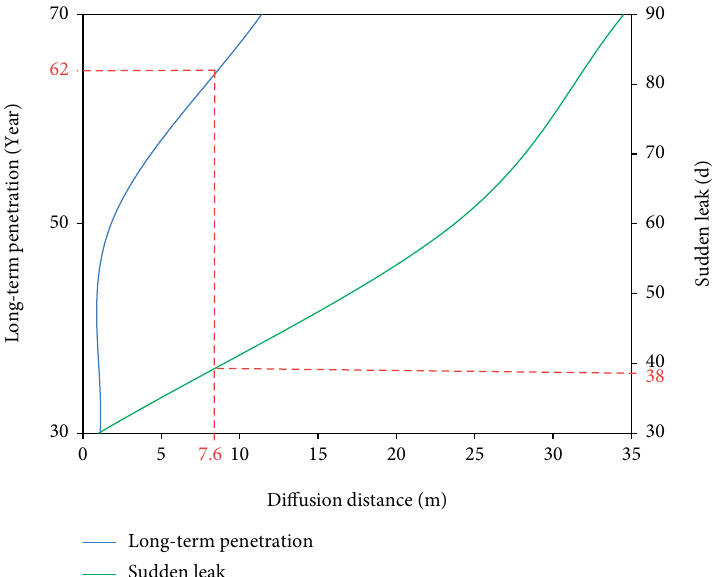
Figure 16: Curves of di ff usion distance of concentrated brine to the water barrier with time for long-term in fi ltration and sudden leakage simulation